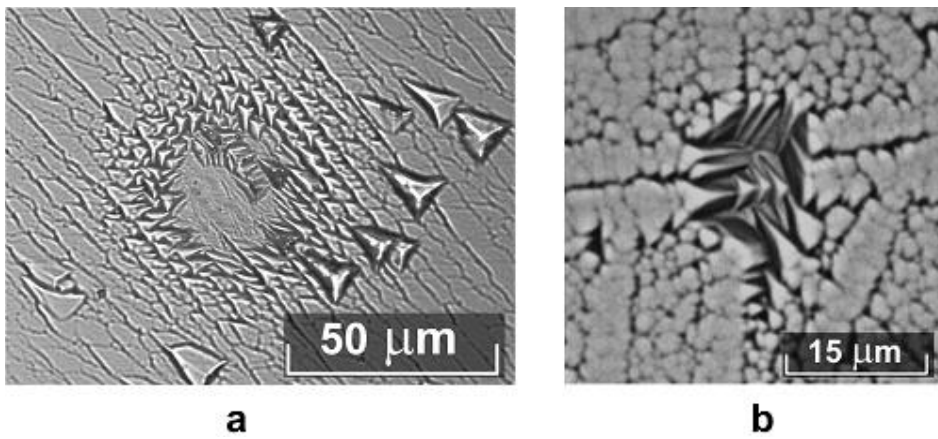
Figure 12. Separation of the second phase with coherent boundaries in the crystal LiNbO 3 :Zn ([Zn] = 4.77 mol.% in the crystal). Z-cut.